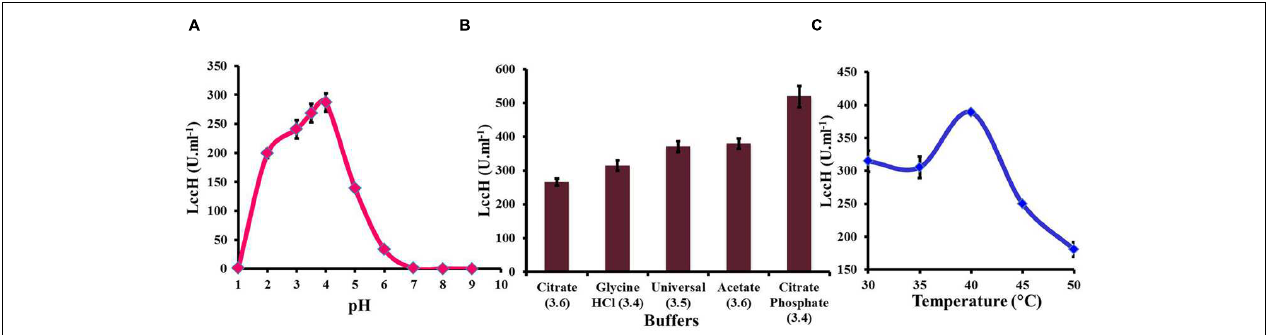
FIGURE 3 | Optimization of assay conditions for LccH activity (A) pH, (B) buffers, and (C) temperature. (A) Effect of pH on LccH activity determined using universal buffer (pH range of 1–9). (B) Effect of different buffers such as citrate (pH 3.6), glycine-HCl (pH 3.4), universal (pH 3.5), acetate (pH 3.6), and citrate phosphate (pH 3.4) and (C) Effect of LccH activity at different temperature (30–50 ◦ C). Activity determination was carried out using 3 mM ABTS as substrate. Error bars indicate standard deviations of triplicate experiments.